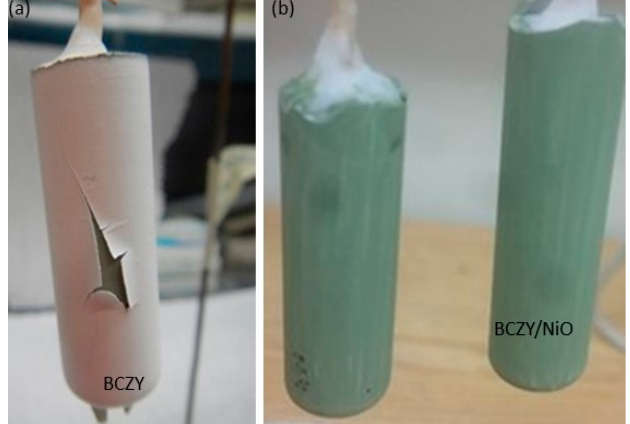
Figure 8. ( a ) BCZY27-NiO tube after the fourth dip coating of the electrolyte layer, ( b ) BCZY27-NiO intermediate layer (ethylcellulose in α -terpineol) painted onto the slip cast tube, prior to slip casting.